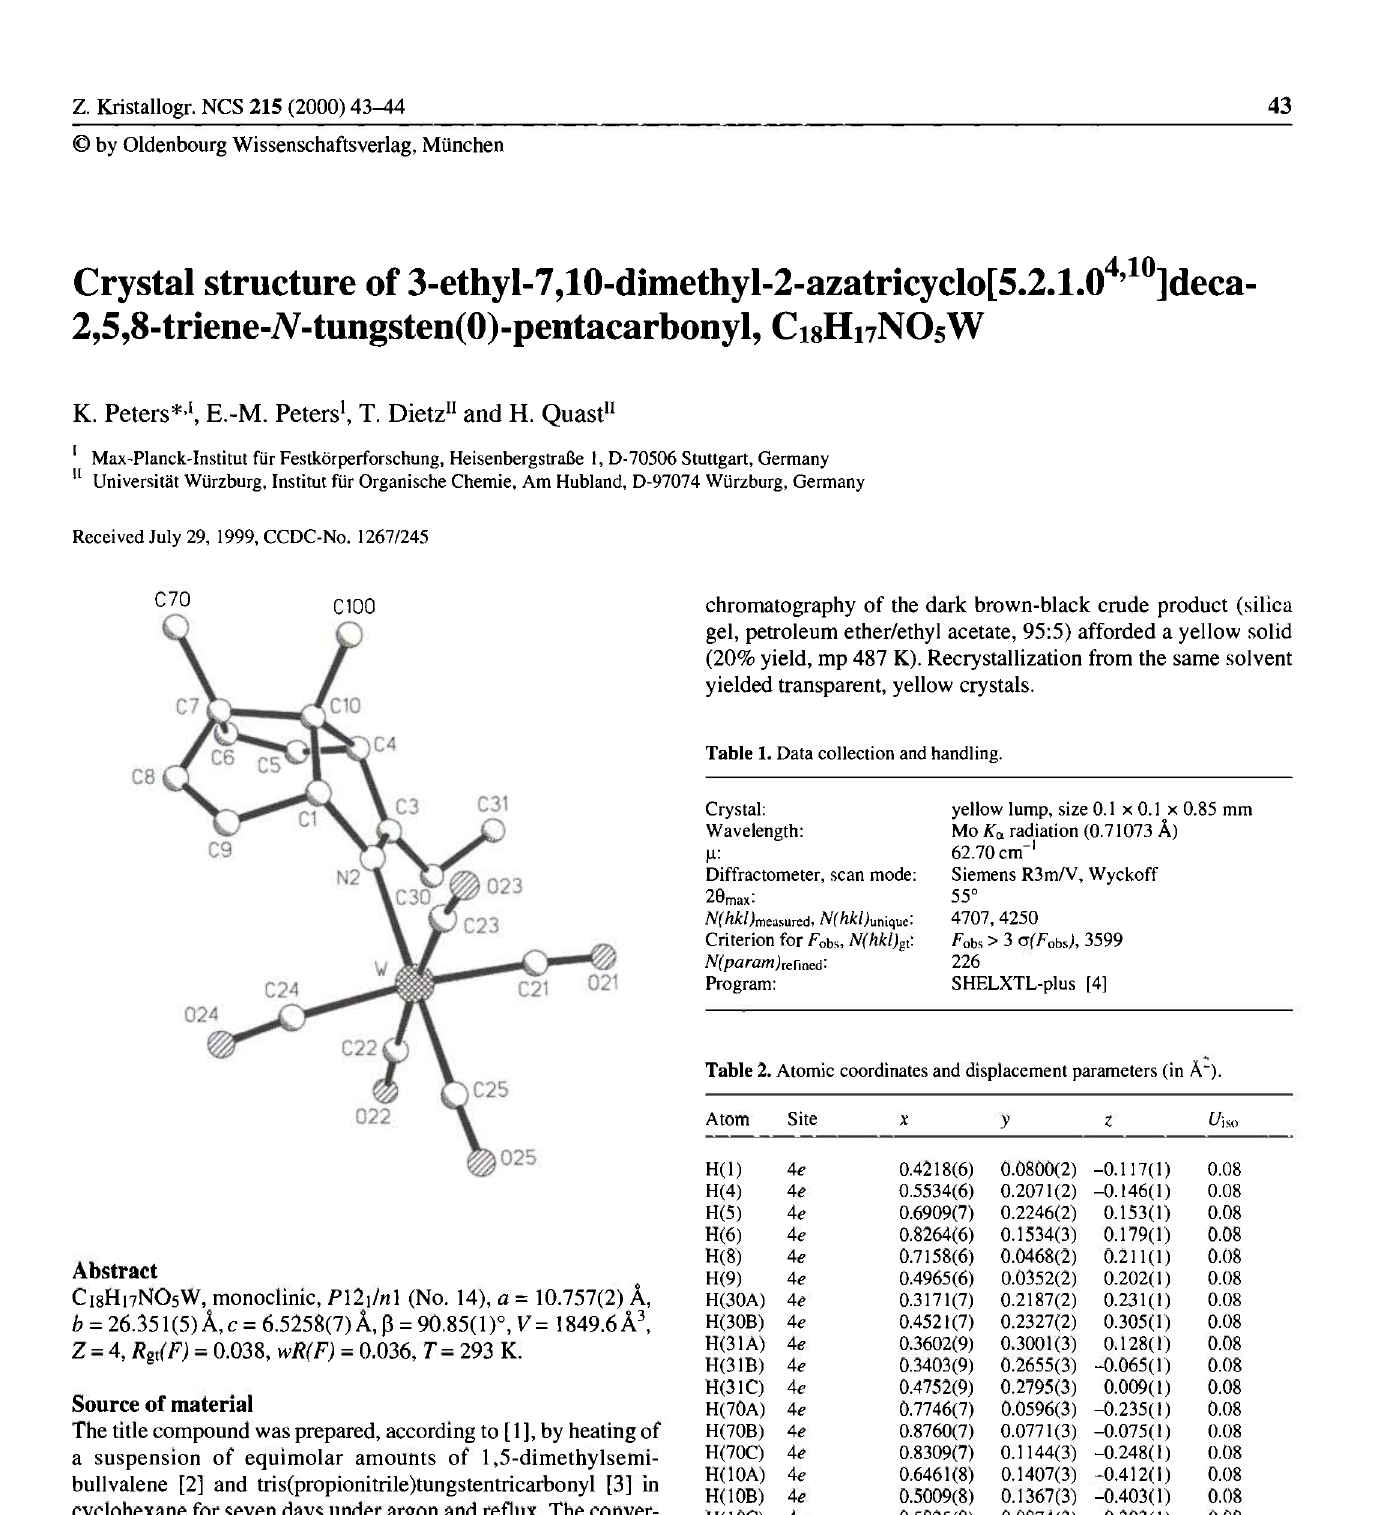
Table 3. Atomic coordinates and displacement parameters (in Ä 2 ).